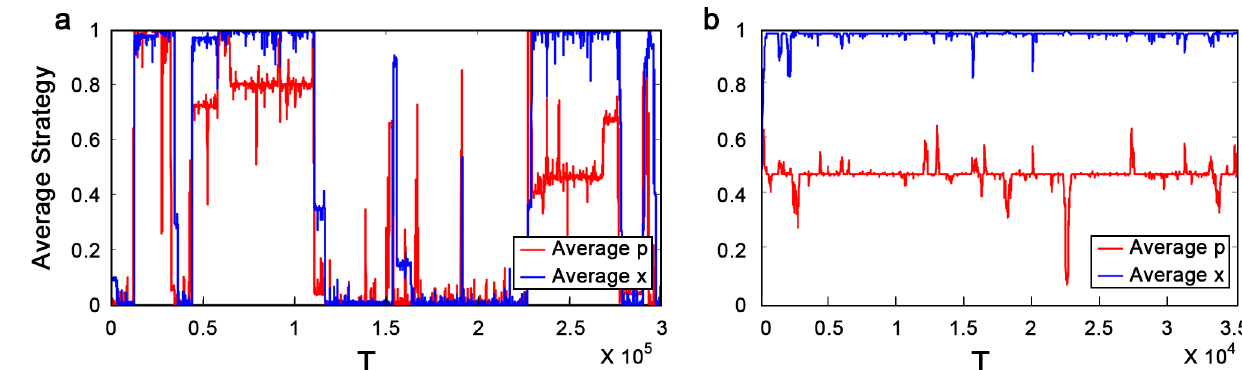
Fig 3. Monte-Carlo simulations for the evolution of conformity in the repeated PD game. The graphs show two typical simulation runs for a population of size 100. At the beginning of each time step, individuals are randomly divided into 50 pairs and play the repeated PD game. In each time step an average of 10 individuals are chosen to update, where they imitate actions that perform better with a probability proportional to the payoffs obtained in the repeated game (i.e., this updating process can be approximately described by the replicator dynamics [48]). In addition, with probability 0.1, one of the 100 individuals is chosen to adopt a new strategy (i.e., the average individual mutation rate is 0.001) by adding a small random value (draw from Gaussian noise (0, 0.1)) on its former strategy. (a) Repeated PD game with (cid:1) n ¼ 6 , R = 3, P = 1, S = 0 and T = 5. The population oscillates between the cooperative boundary x = 1 and the defective boundary x = 0. (b) Repeated PD game with (cid:1) n ¼ 6 , R = 4, P = 2, S = 0 and T = 5. The population can be stabilized at the cooperative